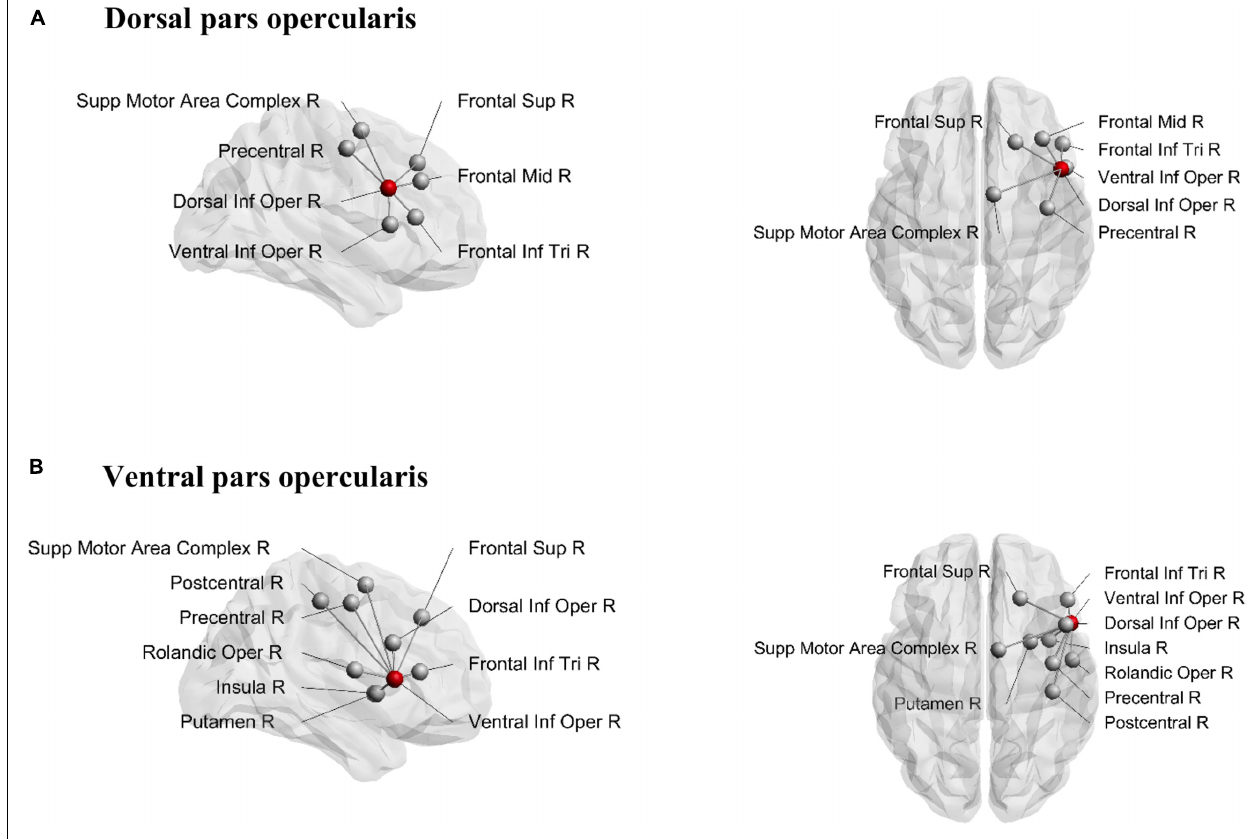
FIGURE 3 | Structural connections from dorsal pars opercularis (A) and ventral pars opercularis (B) . Seeding region is marked as a red node. Sup, superior; Inf, inferior; Mid, middle; Supp, supplementary; Oper, opercularis; Tri, triangularis; R, right.